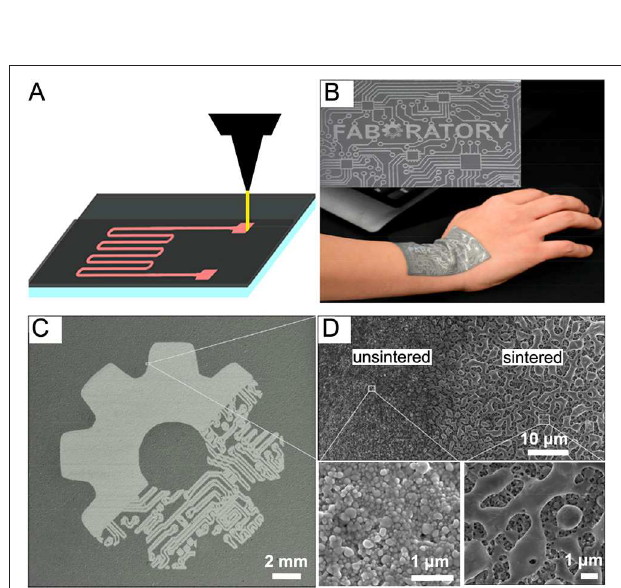
FIGURE 11 | Schematic diagram of laser sintering method of liquid metal nanoparticles (A) , and a soft circuit board printed on a biocompatible substrate adhered to the wrist (B) , and the image of a laser-sintered gear (C) , and the SEM image of a sintered-to-unsintered region with the enlarged view (D) . Reproduced with permissions from Liu et al. (2018). Copyright 2018, American Chemical